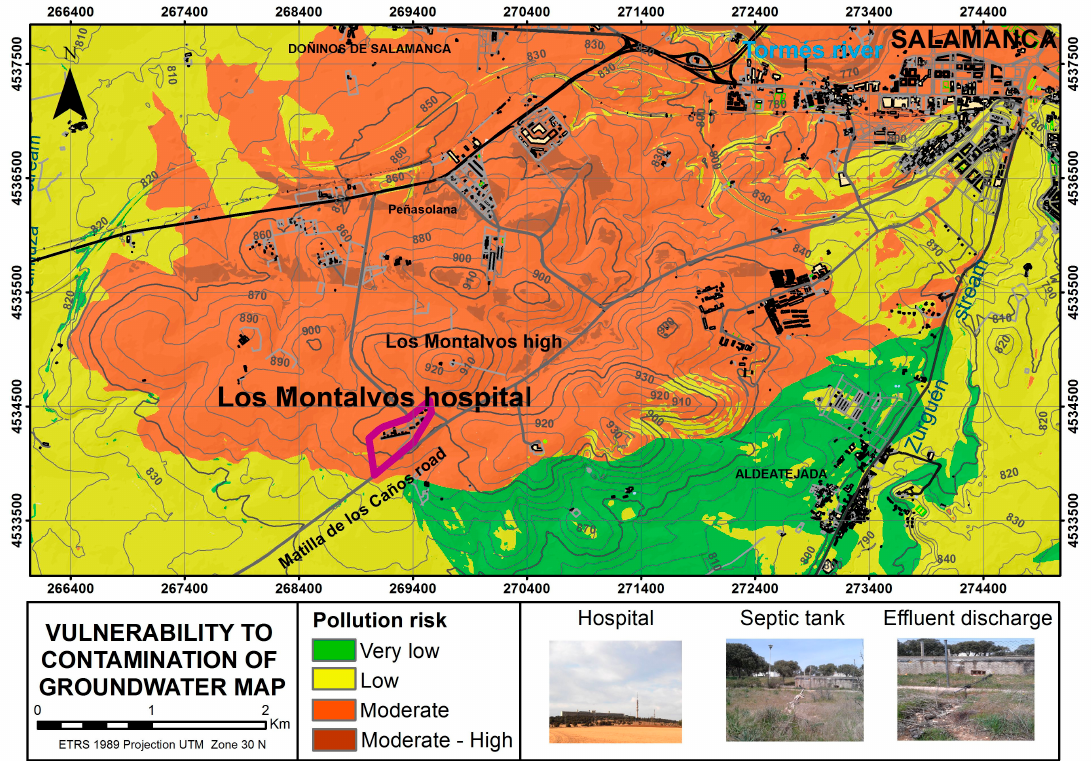
Figure 2. Vulnerability map [3].